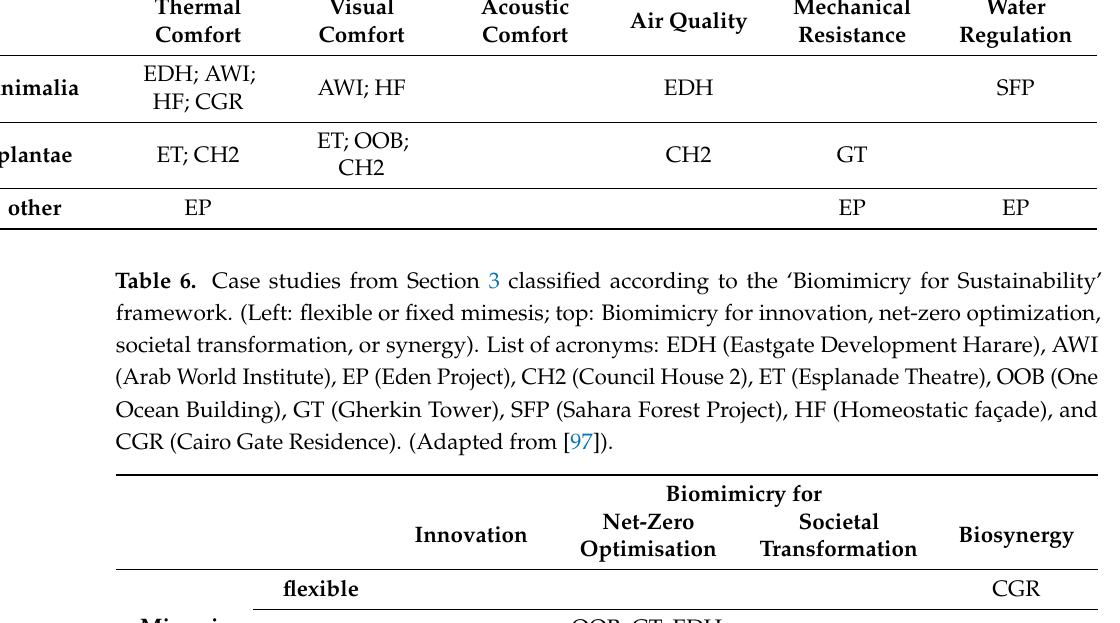
Table 5. Case studies from Section 3 classified according to the checklist of biomimicry for architects. (Left: Inspiration from animalia, plantae, or other; top: Targeted architectural performance in terms of thermal comfort, visual comfort, acoustic comfort, air quality, mechanical resistance, or water regulation). List of acronyms: EDH (Eastgate Development Harare), AWI (Arab World Institute), EP (Eden Project), CH2 (Council House 2), LT (Lotus Temple), ET (Esplanade Theatre), OOB (One Ocean Building), GT (Gherkin Tower), SFP (Sahara Forest Project), HF (Homeostatic façade), and CGR (Cairo Gate Residence). (Adapted from [57]).